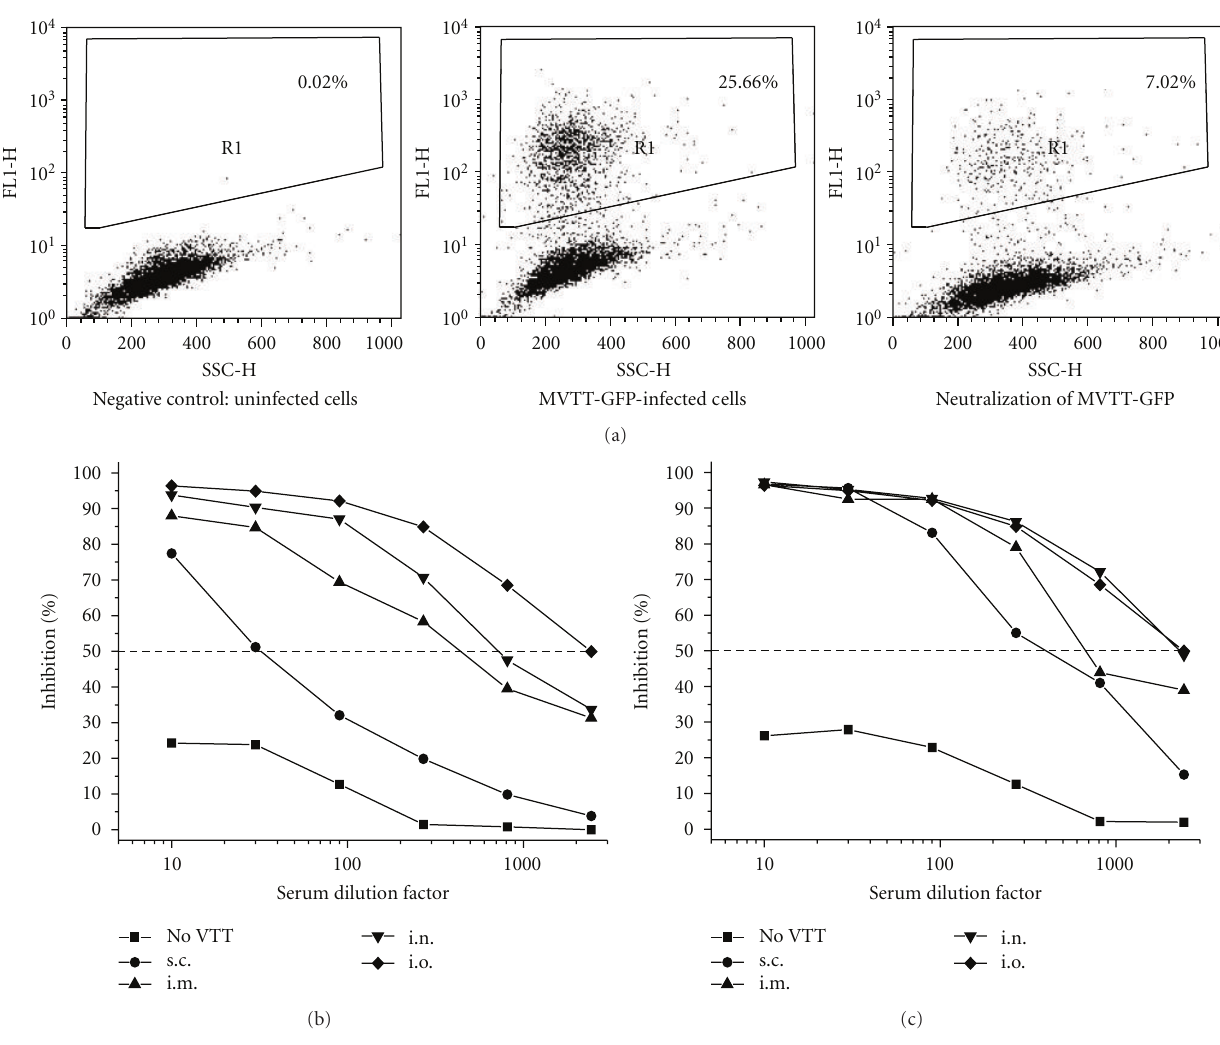
Figure 1: Anti-VTT neutralizing antibody responses after the VTT vaccination. (a) A FACS-based neutralization assay was newly developed to measure the anti-VTT neutralizing antibody responses. (b) Serum samples were tested three weeks after the VTT vaccination. (c) Serum samples were tested six months after the VTT vaccination. Due to a limited amount of serum collected from each mouse, pooled sera, which contain an equal amount of serum of each vaccinated mouse in each group, were subjected to each experiment. The X -axis represents the serum dilution factor whereas the Y -axis indicates the percentage of viral inhibition. An IC 50 value is a serum dilution factor which achieves 50% of viral inhibition as indicated by the dashed horizontal line. The experiment was repeated twice with similar results obtained. Placebo (no VTT) mice were tested as well.